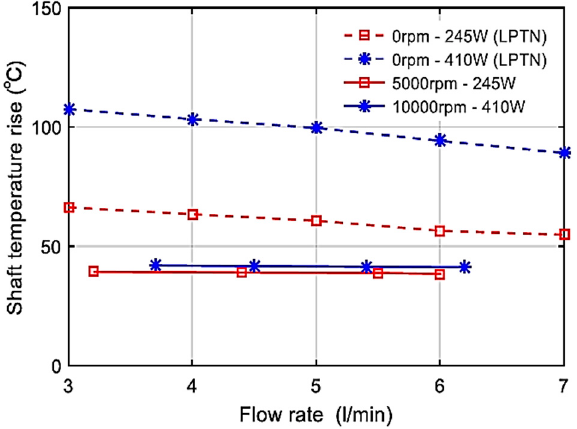
Figure 19. Variation in shaft temperature with different flow rates as regards iron loss [83].